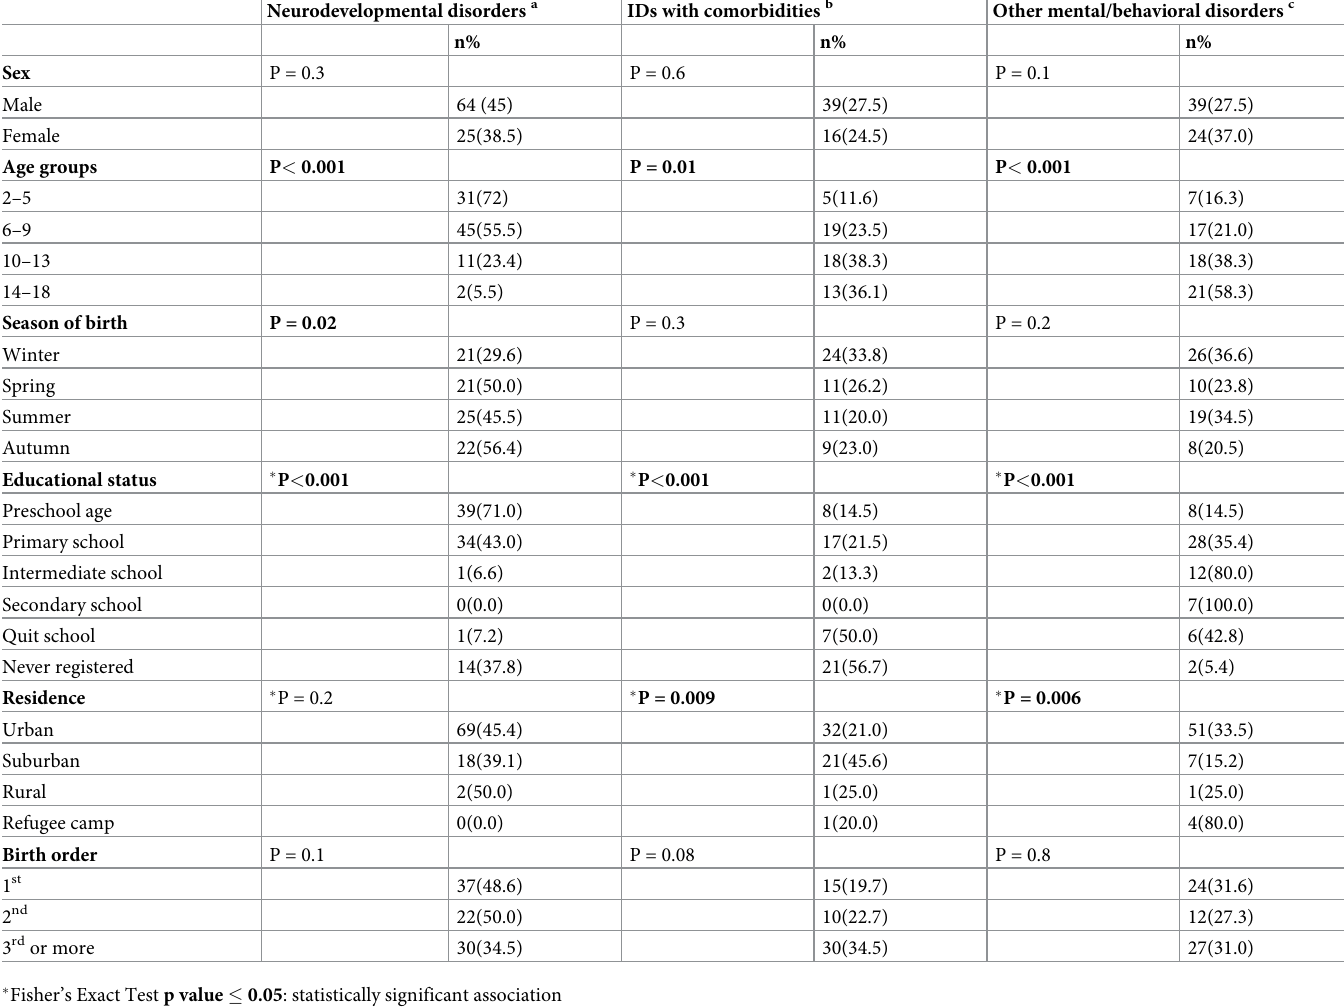
Table 6. Chi-square association tests between sociodemographic variables (individual characteristics) and